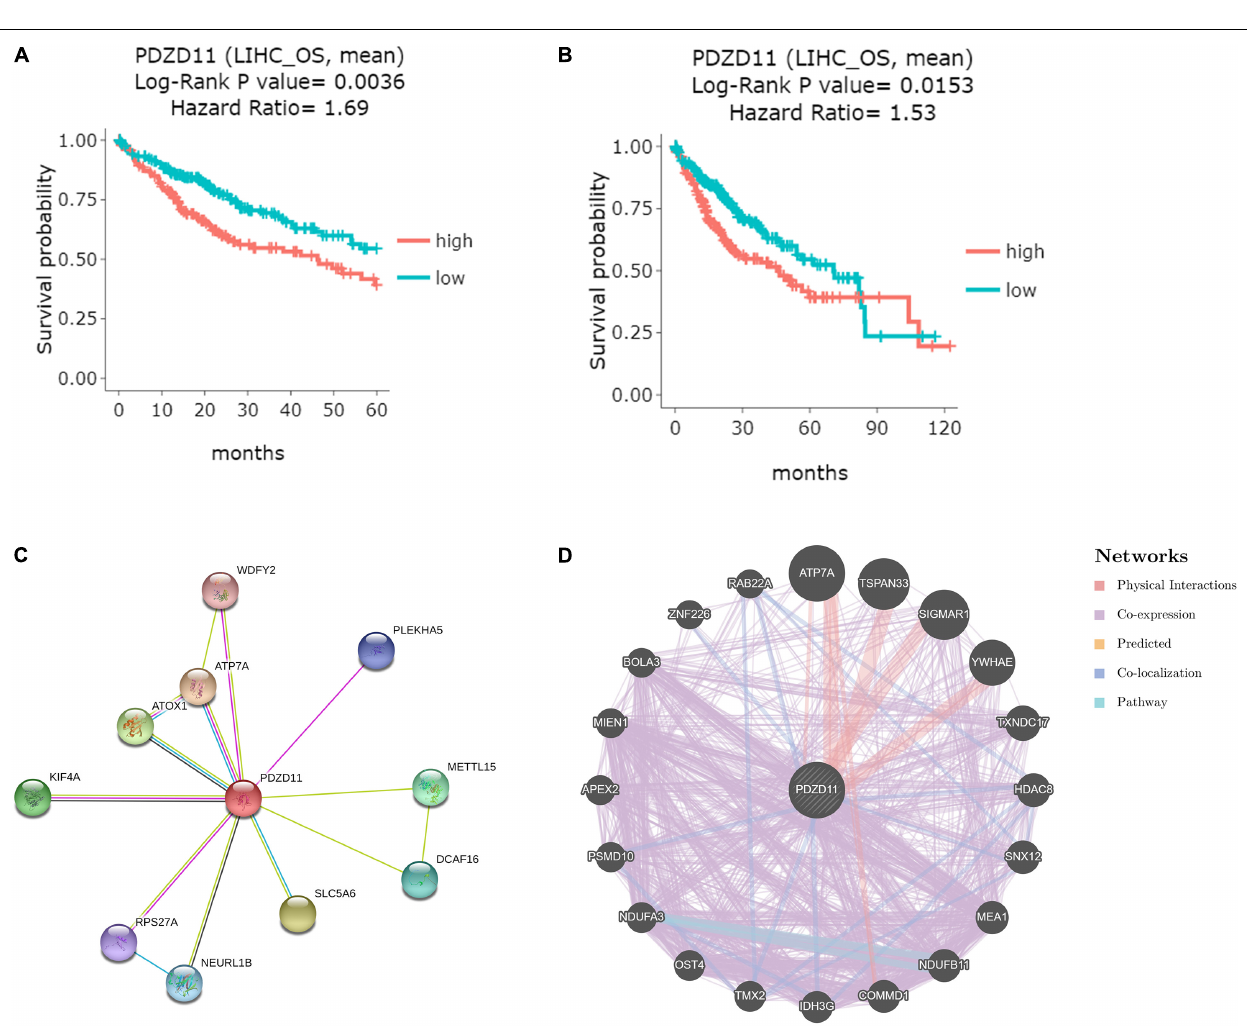
genes with coefficients > 0.3 and < − 0.3. Finally, 617